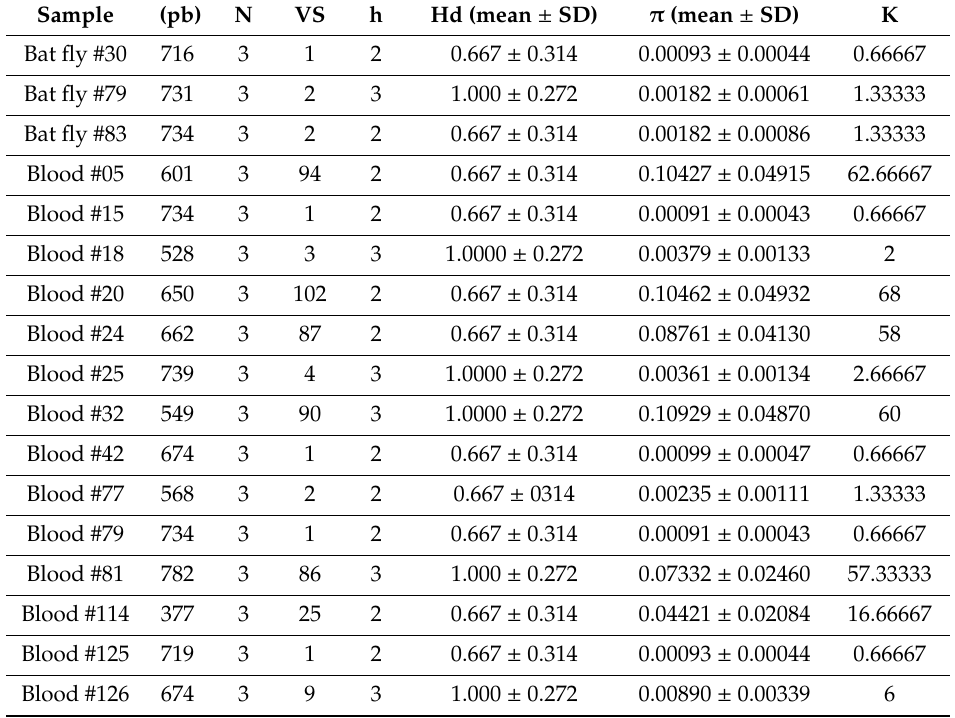
Table 1. Polymorphism found among the three Bartonella gltA cloned sequences obtained from each bat blood and fly sample.